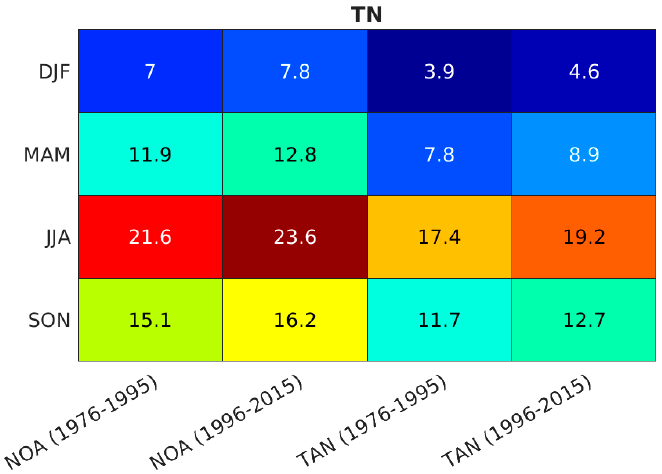
Figure 3. Seasonally averaged minimum temperatures (T min ) for the two reference periods (1976–1995 and 1996–2015) at the meteorological stations of NOA (urban) and TAN (rural). Bootstrap analyses show that spring (MAM), summer (JJA), and autumn (SON) T min values are statistically significantly different between the reference periods at the respective stations.